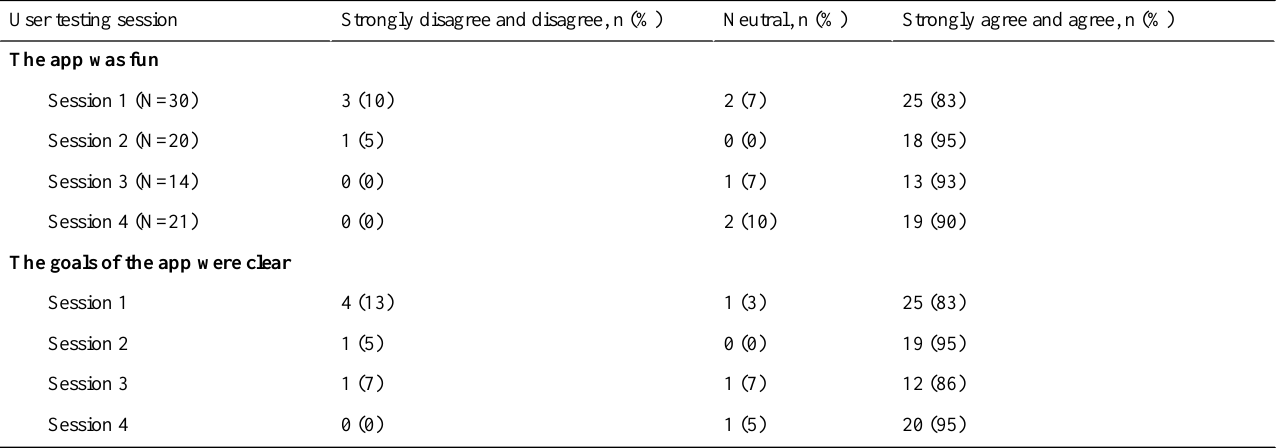
Table 3. Summary of quantitative data for the drinks module (sessions 1-4; session 1 occurred with students in grades 5 to 6. Sessions 2 and 3 occurred with students in grade 4. Session 4 occurred with students in grades 4 to 7.)